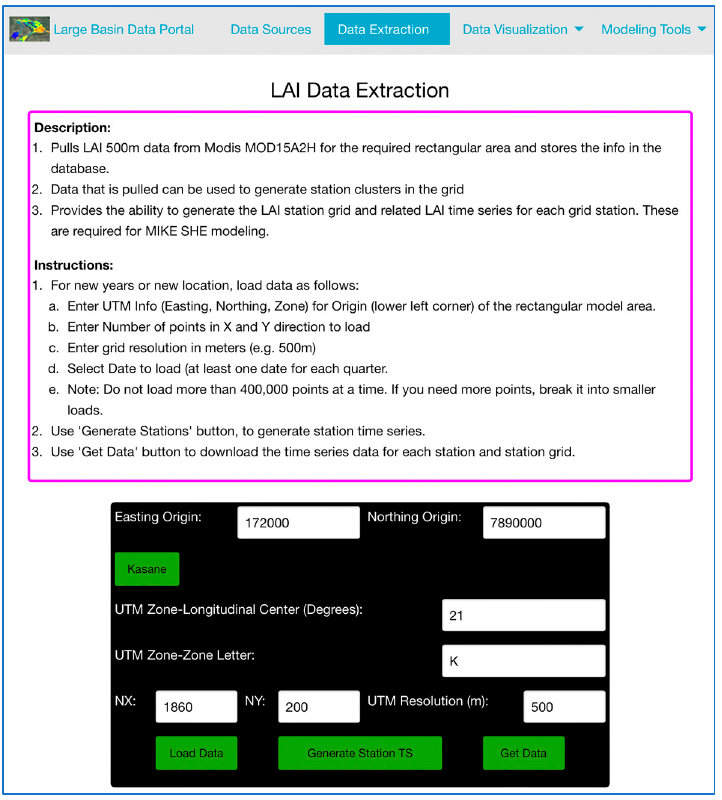
Figure 5. Screenshot of the Large Basin Data Portal Leaf Area Index data extraction tool with descrip- tion, usage instructions, and input parameters.